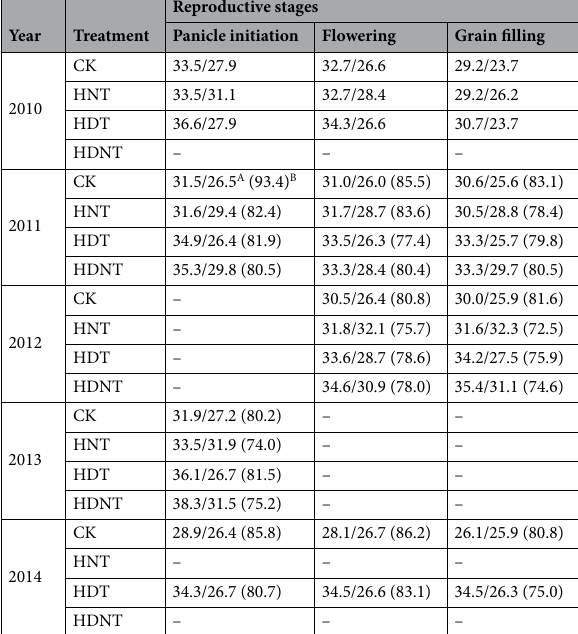
the mean daytime/nighttime temperatures were 34.5 °C/26.3 °C under the HDT temperature treatments, which were approximately 8.4 °C/0.4 °C higher than those of the CK treatment, respectively (Table 1). Responses of rice grain yield and yield components to heat treatments. Heat treatments during the reproductive stages reduced rice grain yield and yield components. Significant differences existed among the three reproductive stages in grain yield ( P < 0.05), seed setting rate ( P < 0.05), spikelet number ( P < 0.01), and grain weight ( P < 0.01), among the three cultivars in grain yield ( P < 0.05) and spikelet number ( P < 0.01), and among the three heat treatments in grain weight ( P < 0.01). No significant interactions were found among the reproductive stages, cultivars and heat treatments except for grain weight, which was significantly affected by ( P < 0.01) the interaction between reproductive stage and cultivar/heat treatment (Table 2). On average, heat treatments during the panicle initiation, flowering and grain filling stages reduced the grain yield by 49.2%, 25.0% and 16.4% in Nagina22, by 19.5%, 34.1% and 16.5% in Shanyou63, and by 40.0%, 55.9% and 28.7% in Liangyoupeijiu, respectively, across the HNT, HDT, and HDNT treatments. The seed setting rate decreased by an average of 30.9%, 11.2% and 9.8% in Nagina22, 11.7%, 34.7% and 17.2% in Shanyou63, and 18.6%, 52.3% and 25.8% in Liangyoupeijiu under heat stress during the panicle initiation, flowering and grain filling stages, respectively, across the three heat treatments (Table 2). The spikelet number decreased by an average of 14.3%, 5.5% and 1.9% in Nagina22, by 3.3%, − 1.4% and − 0.8% in Shanyou63, and by 23%, 5.1% and − 0.9% in Liangyoupeijiu when heat stress was imposed during the panicle initiation, flower- ing and grain filling stages, respectively, across the three heat treatments. Grain weight decreased by an average of 10.1%, 0.4% and 4.9% in Nagina22, by 5.4%, 1.5% and 3.6% in Shanyou63, and by 8.2%, 0.8% and 2.5% in Liangyoupeijiu under heat stress during the panicle initiation, flowering and grain filling stages, respectively, across the three heat treatments. Heat stresses had negligible effects on panicle number in the three rice cultivars (Nagina22, Shanyou63 and Liangyoupeijiu) during the three reproductive stages (Table 2). Average yield response and yield stability of different rice cultivars under heat stress. Figure 1 shows the results view of mean relative grain yields and yield components vs. stability of these yield character- istics by genotype and genotype by environment interaction biplot analysis. The averages of relative grain yields and relative yield components across heat treatments and experimental years for the three rice cultivars were approximated by the projections (indicated by dotted line) of their markers onto the average environmental coordinate (AEC). The double arrow that runs parallel to the x-axis indicates the direction of yield performance of the different cultivars. Shanyou63 maintained the highest average grain yield under heat stress during the three reproductive stages, followed by Nagina22 and Liangyoupeijiu (Fig. 1A). Each cultivar’s resilience to heat stress (stability) was estimated by its projection (dotted line) on the AEC y-axis. The double arrow that parallels